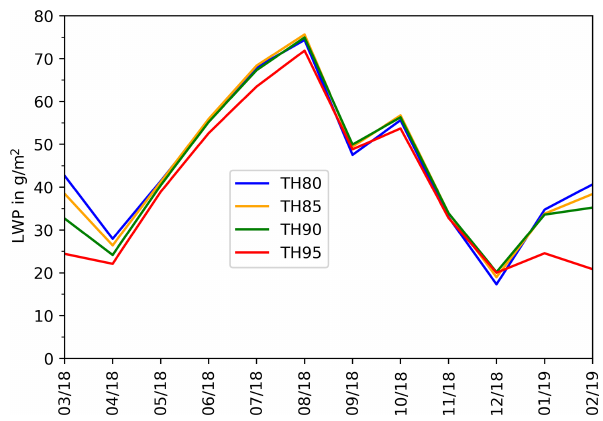
Figure 9. Annual course of monthly means of LWP. Different col- ors depict different LWP retrievals (see Sect.